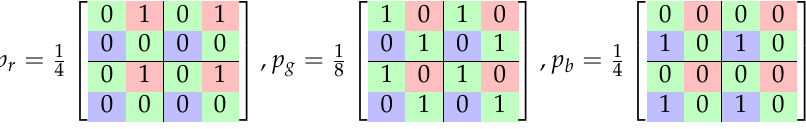
Figure 7. Naive averaging masks ( W = 2).